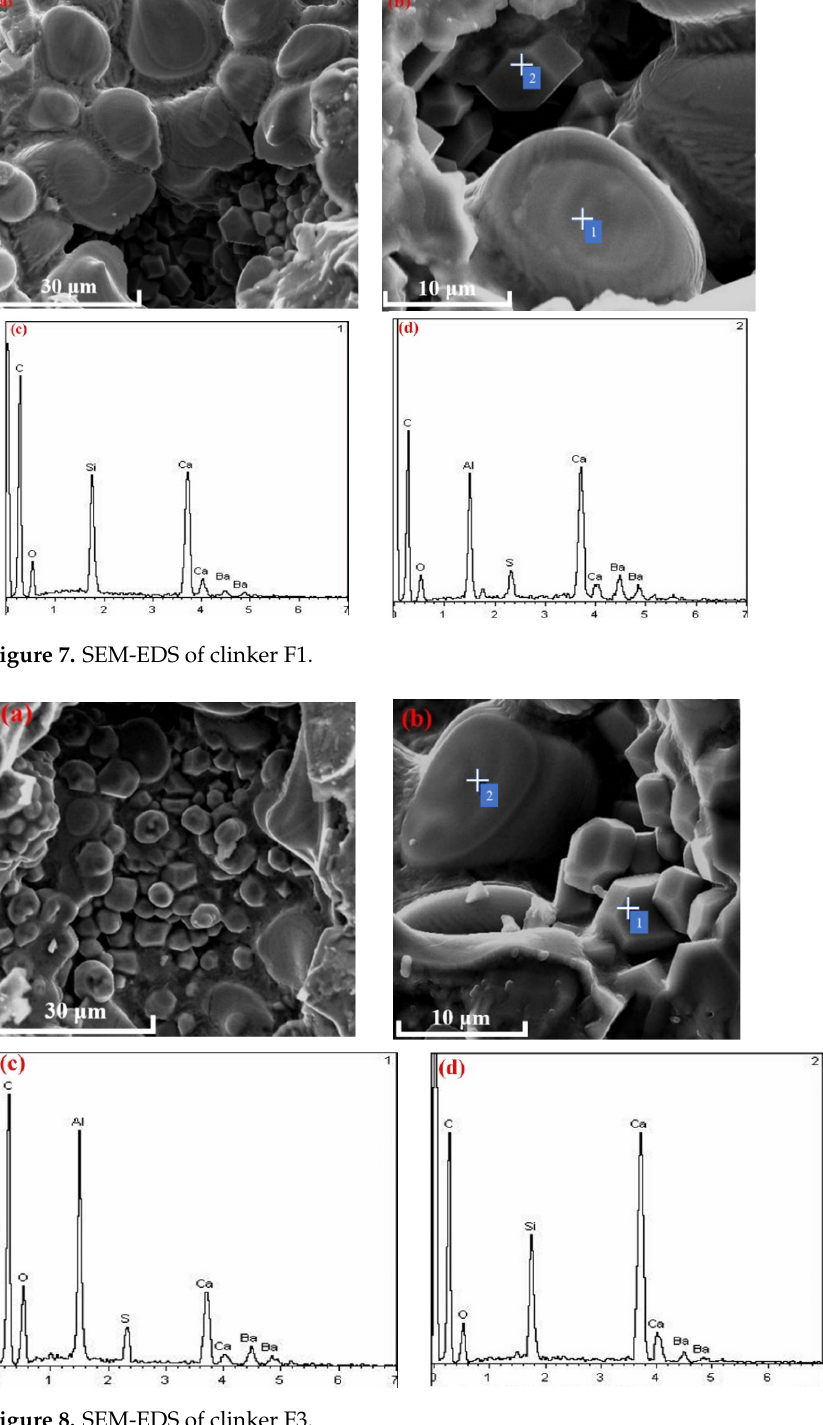
Figure 8. SEM-EDS of clinker F3.